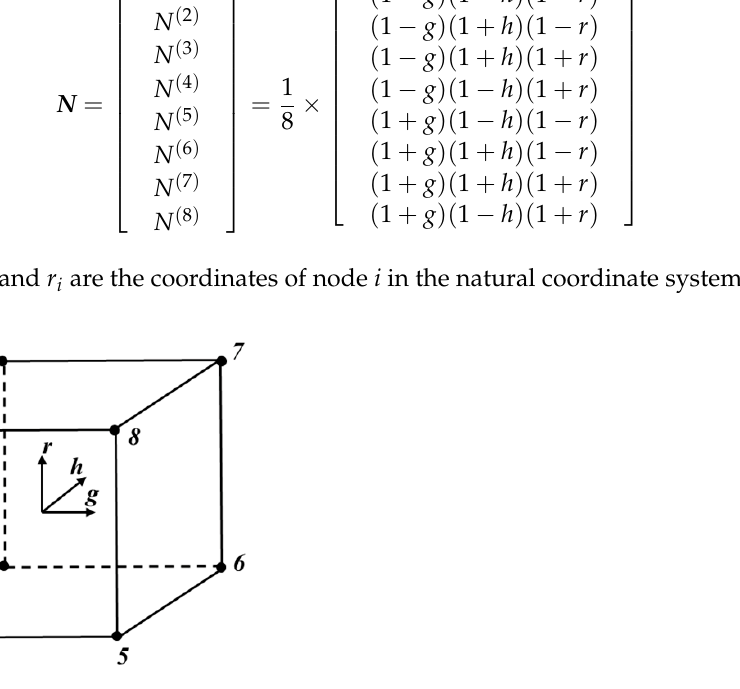
Figure A1. Local node numbering of the first-order brick element in the natural coordinate system.